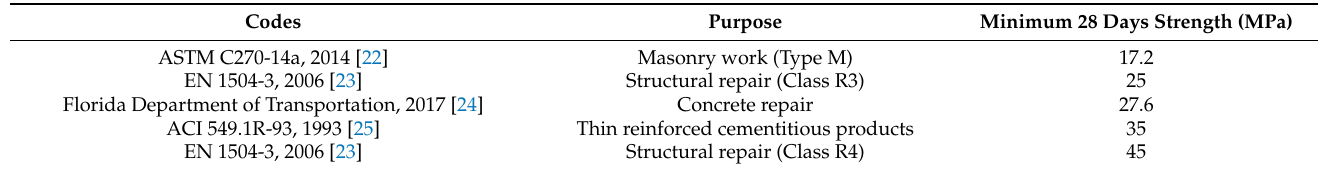
Table 1. Strength criteria for structural mortar in accordance with various